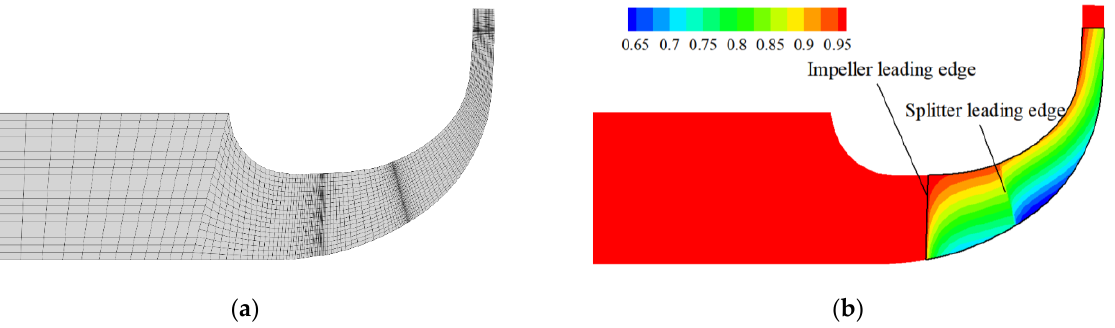
Figure 7. Computational grid and blockage distribution of HPCC test case. ( a ) Computational mesh; ( b ) blockage distribution.